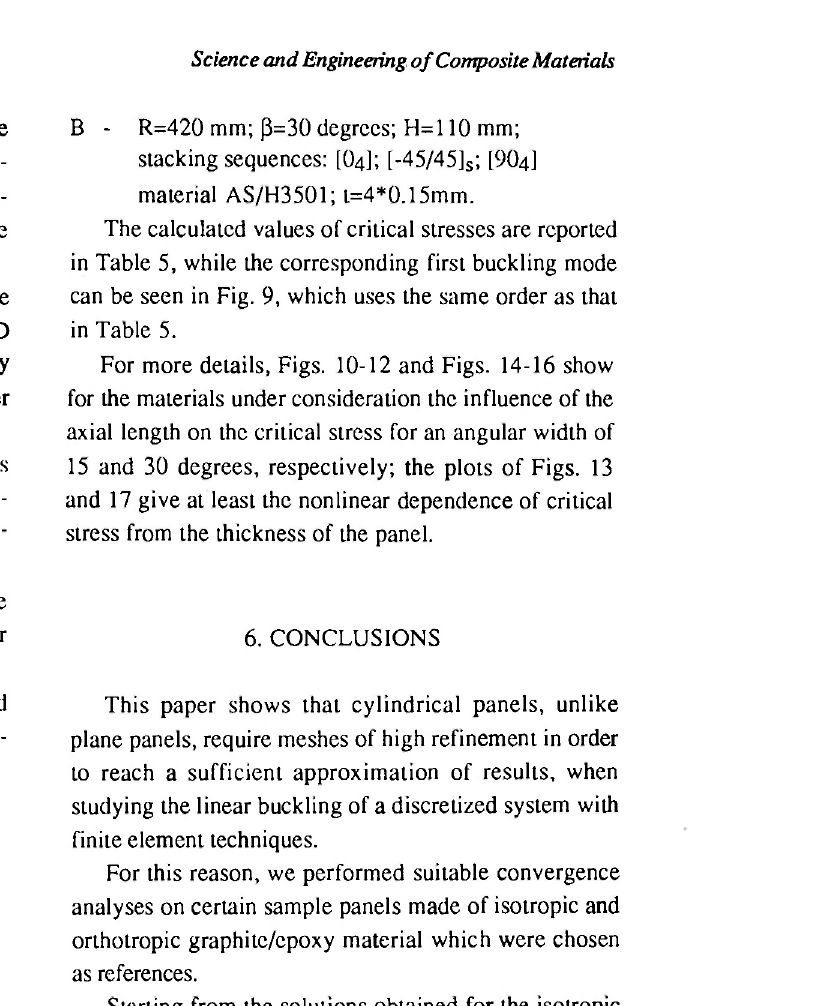
Fig. 8: Influence of linear density on the solution for H=330mm.